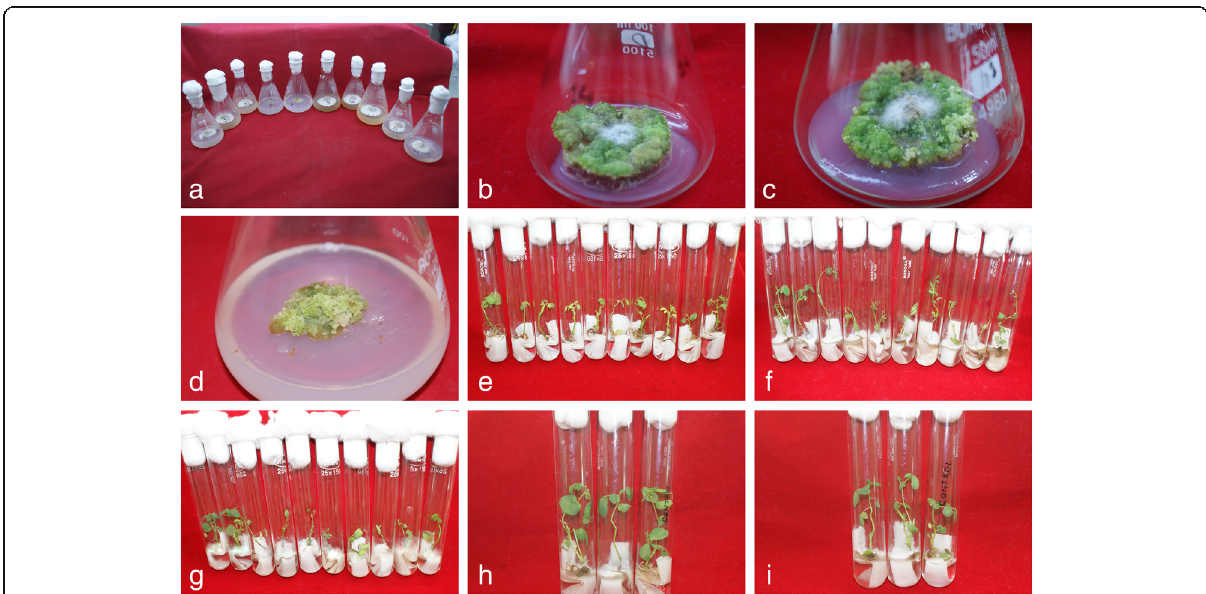
Fig. 2 a Effect of Fsd isolate 1145 on in vitro raised callus of D. sissoo genotypes, from left to right genotype 19, 237, 204, 14, 66, 41, 232, 10, 24, and 20. b Callus of genotype 14 inoculated with Fsd (1149) after 30 days of infection. c Callus of genotype 66 inoculated with Fsd (1145) after 30 days of infection. d Control for ( a ). e Control for ( f and g ; from left to right genotypes 14, 66, 232, 237, 204, 24, 19, 41, 201 and 10). f Effect of Fsd isolate 1145 on in vitro raised plantlets of ten genotypes of D. sissoo (from left to right genotypes 14, 66, 232, 237, 204, 24, 19, 41, 201 and 10). g Effect of Fsd isolate 1149 on in vitro raised plantlets of ten genotypes of D. sissoo (from left to right genotypes 14, 66, 232, 237, 204, 24, 19, 41, 201 and 10). h Plantlets of genotype 14 infected with both isolates of Fsd 1149 (left most test tube) and 1145 (second test tube from left) and uninfected control (third test tube from left) after 3 weeks of infection. i Plantlets of genotype 66 infected with both isolates of Fsd 1149 (left most test tube) and 1145 (second test tube from left) and uninfected control (third test tube from left) after 3 weeks of